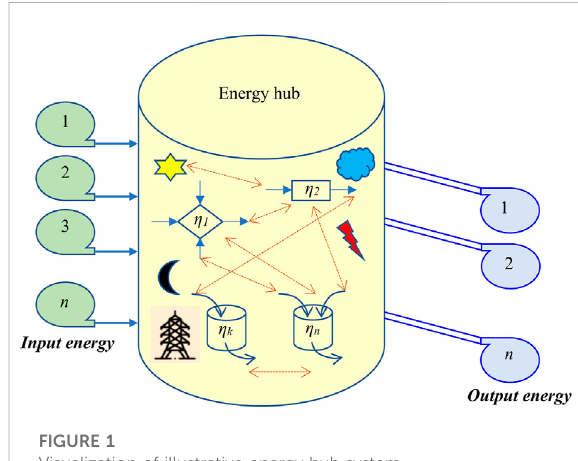
FIGURE 1 Visualization of illustrative energy hub